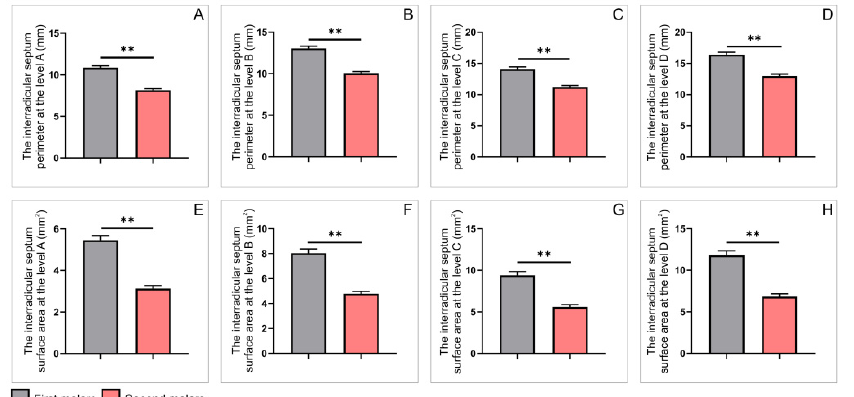
Figure 6. The parameters obtained on axial slices for all upper molars: ( A – D ) the interradicular septum perimeter (in mm) at the levels A–D, respectively; ( E – H ) the interradicular septum surface area (in mm 2 ) at the levels A–D, respectively. Values are expressed as the mean ± SEM. ** Denotes a significant difference, p < 0.01.